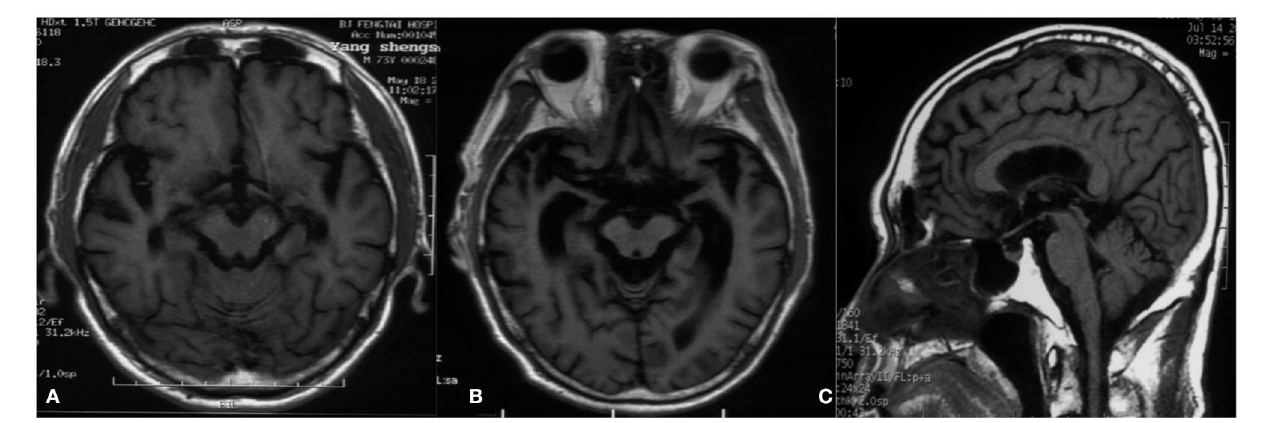
FIGURE1 Magnetic resonance imaging. (A) T1-weighted image 2 months after the onset of the disease shows extensive cortical atrophy. (B) T1-weighted image 12 months after the onset of the disease reveals severe cortical atrophy, and the degree of atrophy gradually increased compared to A. (C) T1-weighted image 4 months after the onset of the disease demonstrates that the midbrain volume was comparatively well preserved compared with cortical atrophy.